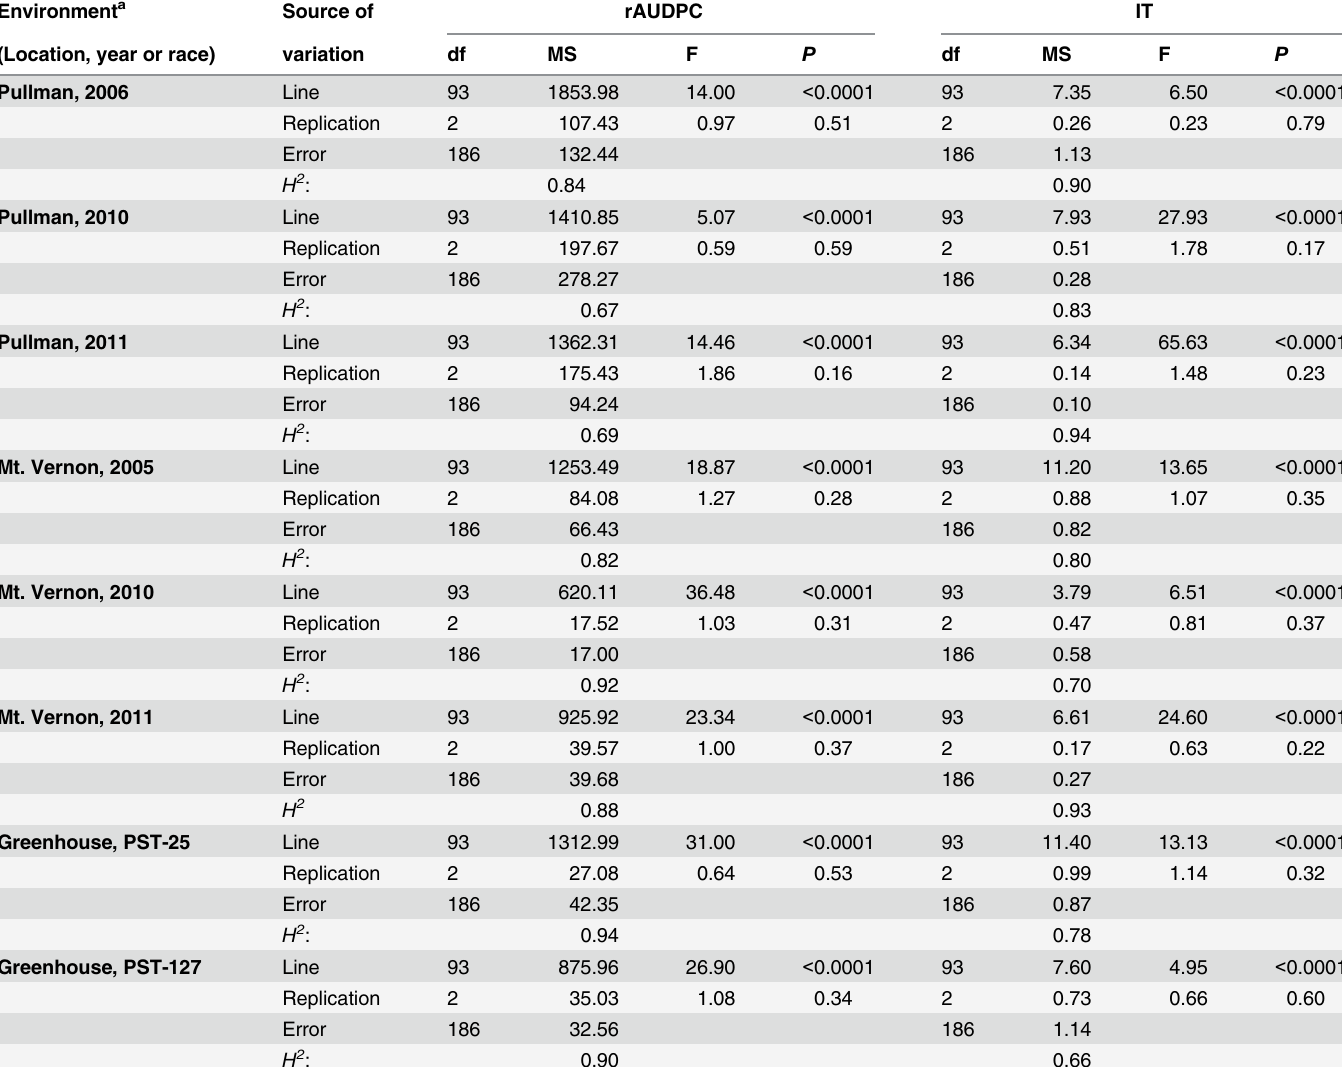
Table 2. Analysis of variance and estimates of broad-sense heritabilities (H 2 ) of relative area under the disease progress curve (rAUDPC) and in- fection type (IT) scores of the recombinant inbred lines derived ted from the Druchamp × Michigan Amber